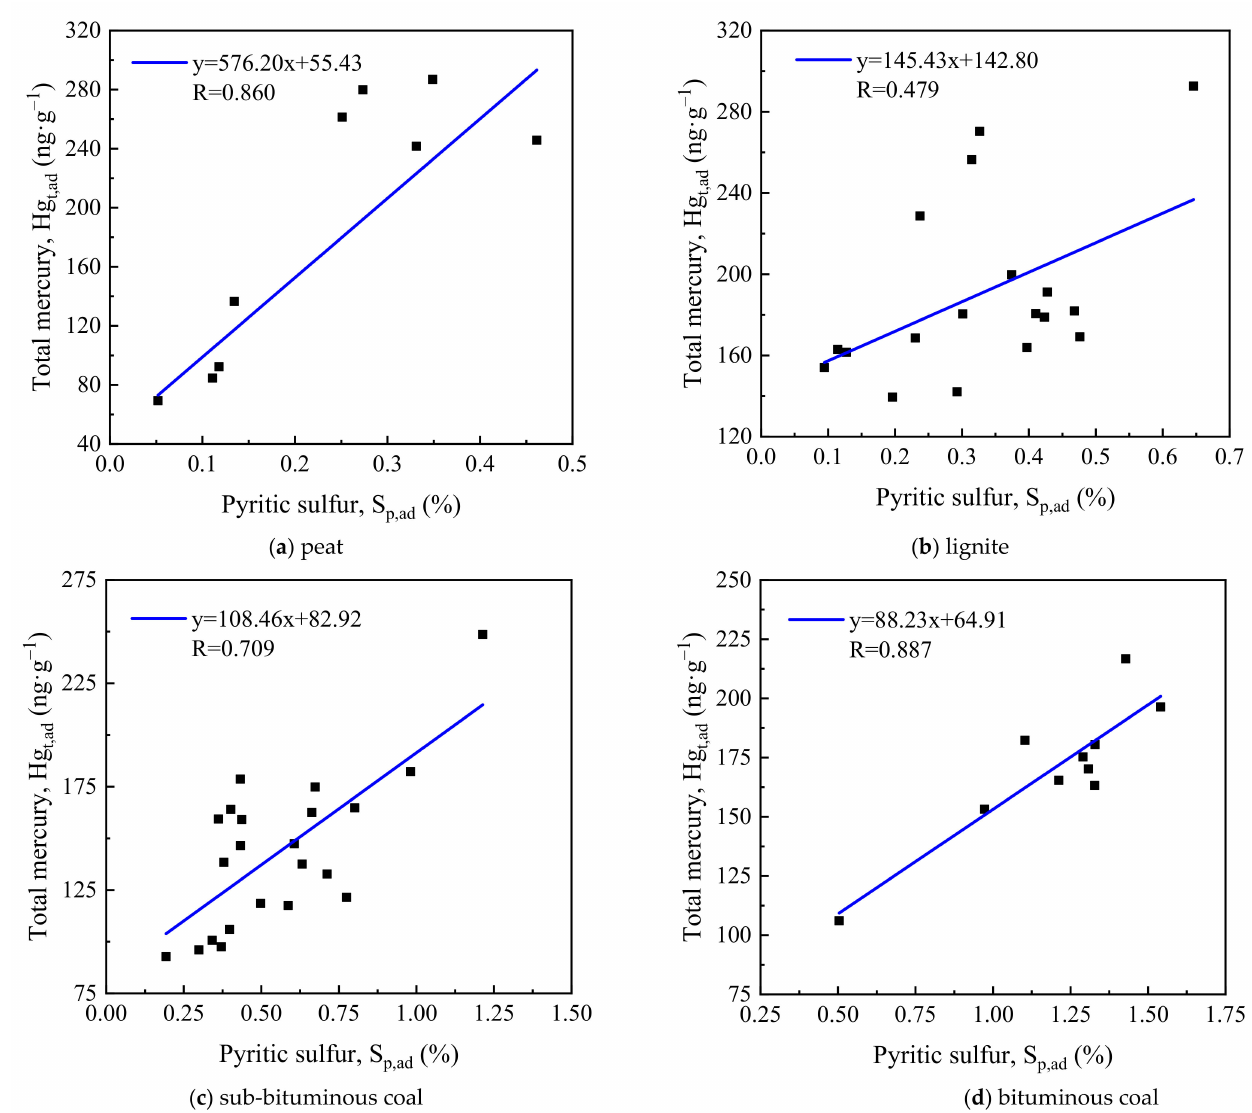
Figure 13. Correlation between Hg and pyritic sulfur for coal samples with different